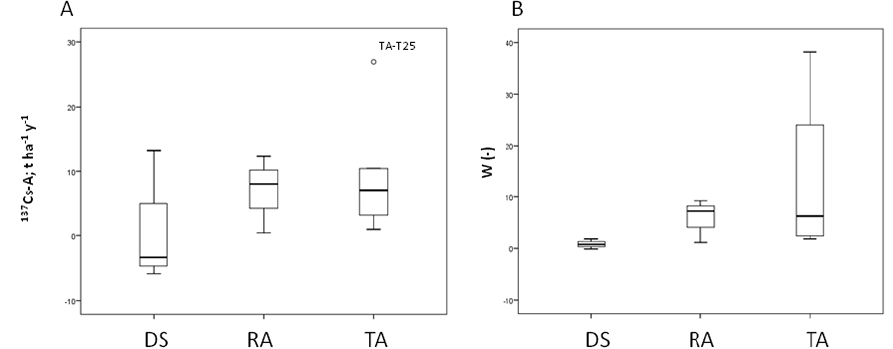
Figure 5. Box plots of (A) the difference between 137 Cs and RUSLE estimates ( 137 Cs- A ;tha − 1 yr − 1 ) and (B) winter factor ( W , dimension- less) for the three different subareas (RA: release area; DS: defense structures; TA: track area).